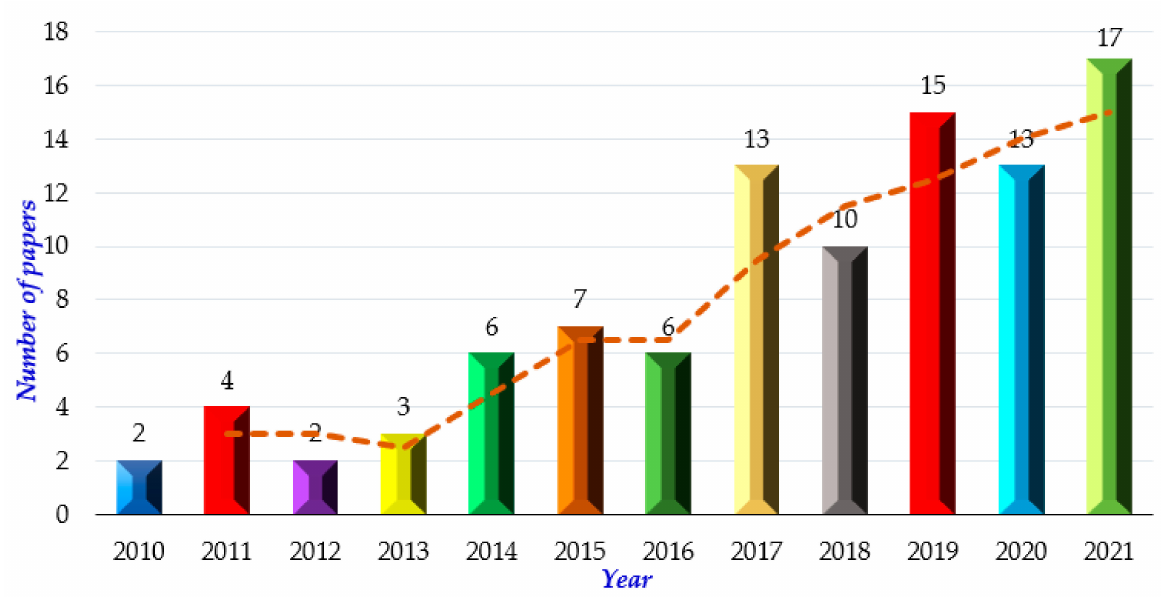
Figure 4. Distribution of selected research articles from 2010 to